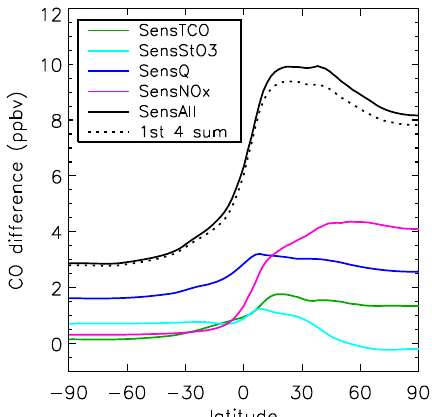
Figure 11. Zonal mean surface CO difference compared to RefCO–OH for the CO–OHSensTCO (green), CO–OHSensStO3 (cyan), CO–OHSensQ (blue), CO–OHSensNOx (pink), and CO– OHSensAll (solid black) simulations averaged over March through August of 2005 to 2009. The sum of the differences for the CO–OHSensTCO, CO–OHSensStO3, CO–OHSensQ, and CO– OHSensNOx compared to RefCO–OH is shown as the black dotted